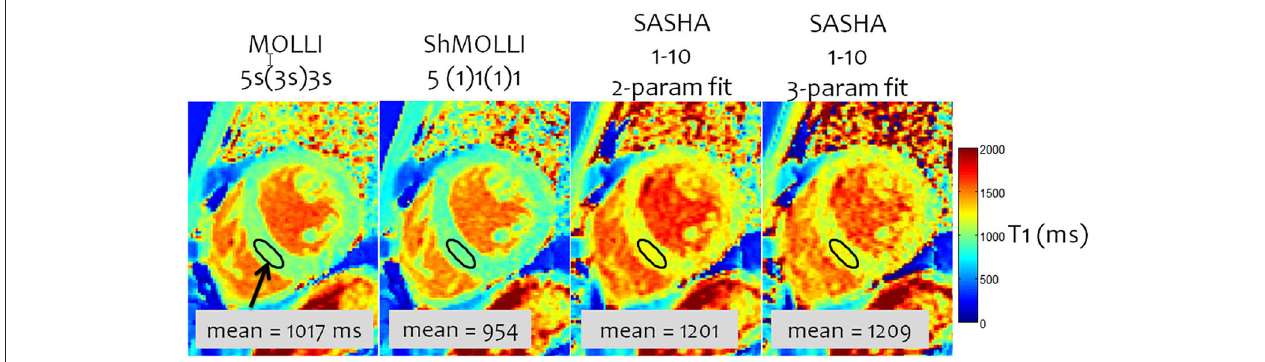
FIGURE 3 | A comparison of inversion- and saturation-based myocardial T 1 mapping sequences. MOLLI has the lowest variability due to the inversion and large number of samples, but the lowest accuracy because of the approximate nature of the Look-Locker correction and magnetization transfer. SASHA with a 2-parameter fitting has a small T 1 underestimation; 3-parameter fitting is more accurate but has a significantly higher variability. Adapted from Kellman and Hansen (20) with